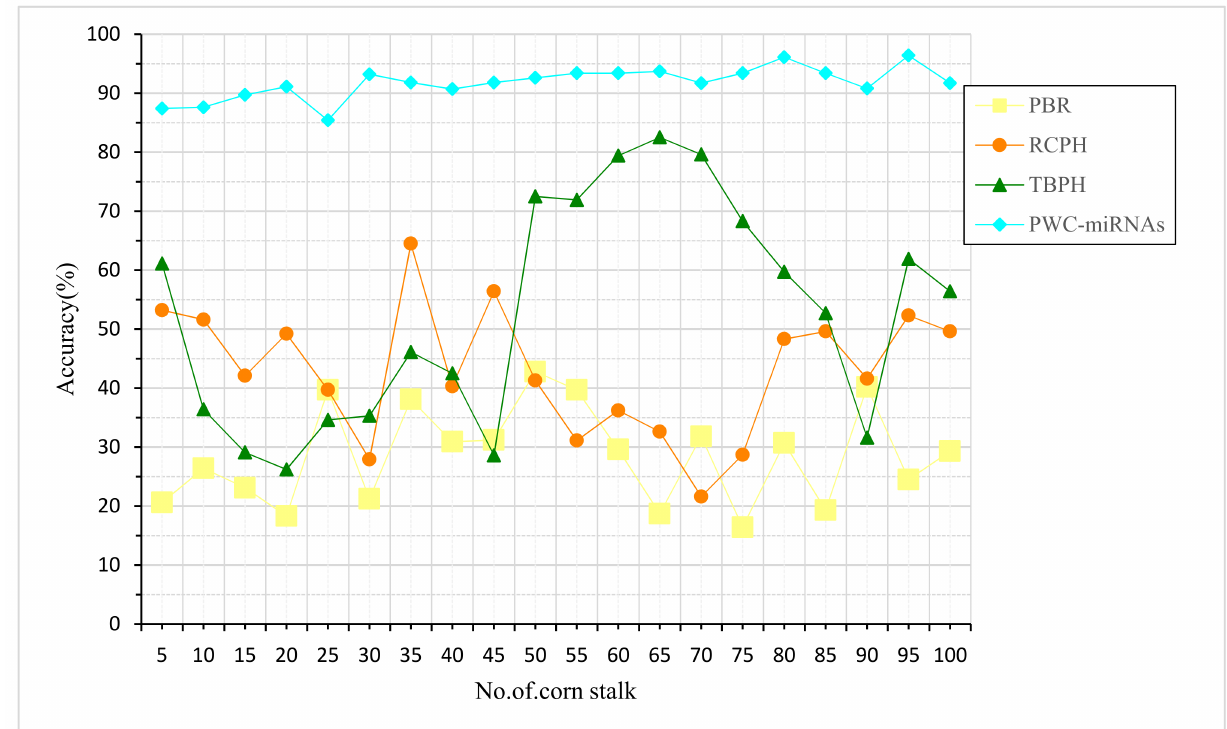
Figure 5. Accuracy of sugar content based on PWC-miRNAs.